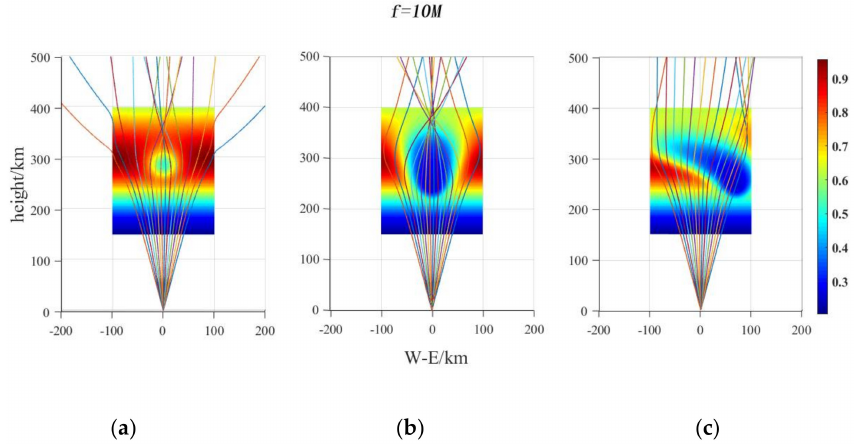
Figure 5. 3D ray-tracing simulation of 10 MHz short wave propagation path after 100 s of H 2 released by rocket under different flight paths (electron density unit: 10 6 cm − 3 ): ( a ) 300 km fixed − point